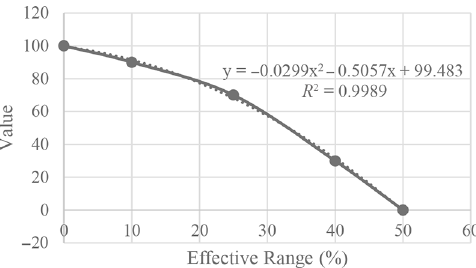
Figure 5. Maximum range